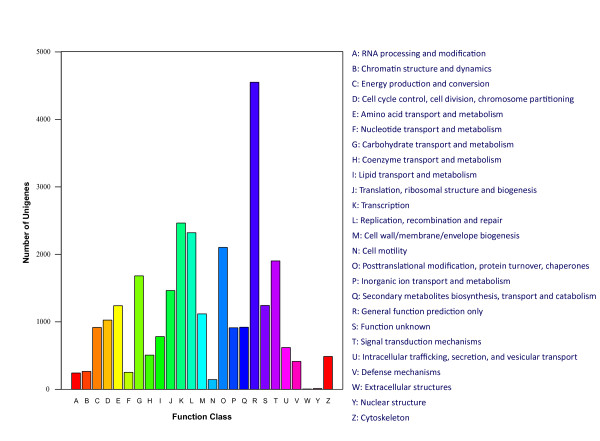
Clusters of orthologous groups (COG) classification. In total, 27,588 of the 46,479 sequences with Nr hits were grouped into 25 COG classifications.